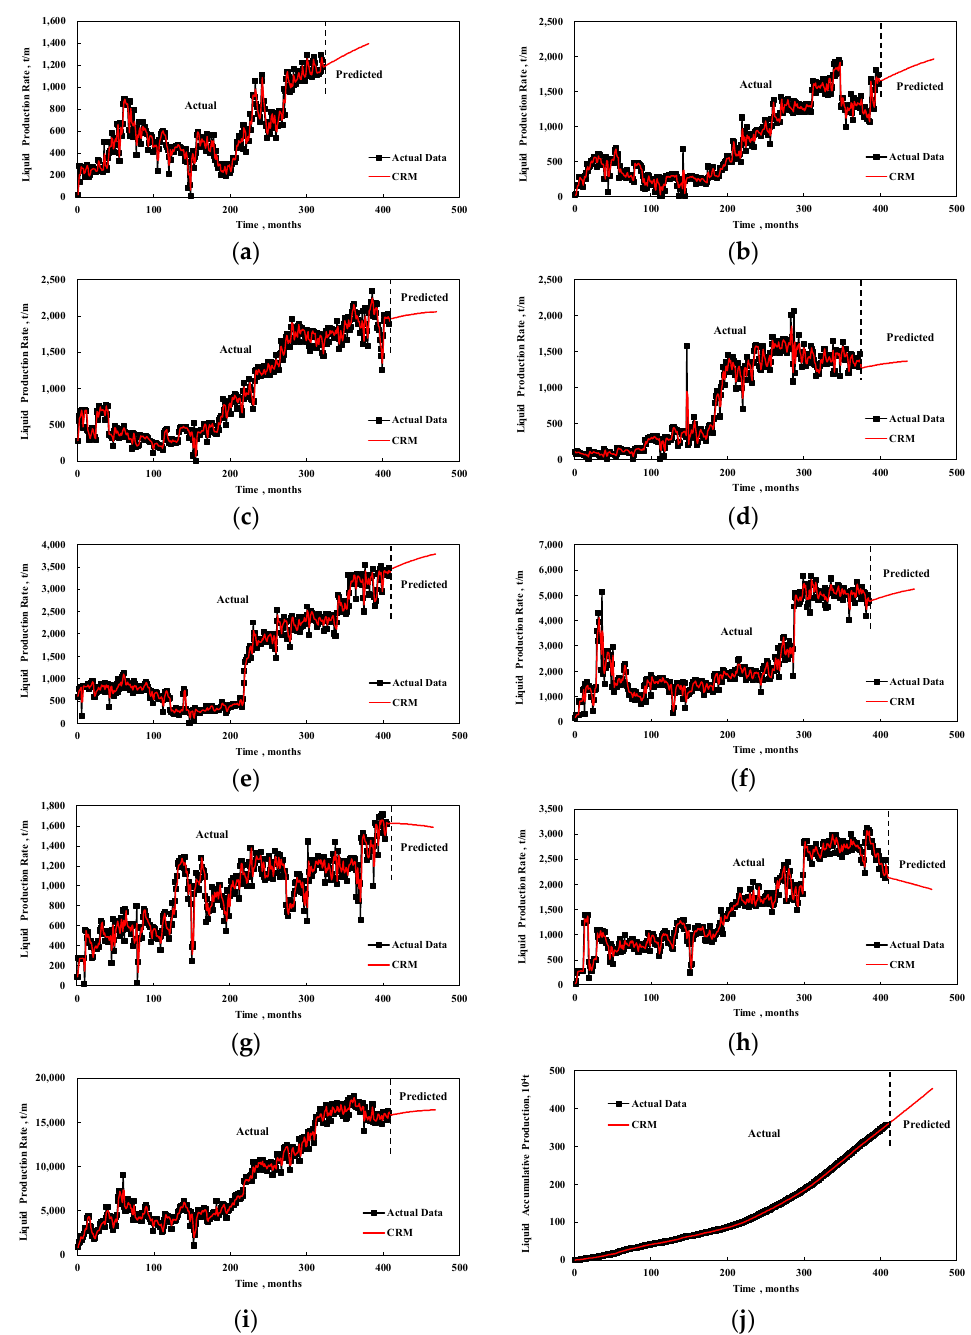
Figure 5. Comparison between actual liquid production data and calculated liquid production data by combining modified CRM and waterflooding performance equation. ( a ) Producer 1499, ( b ) Producer 1500, ( c ) Producer 1501, ( d ) Producer 1511, ( e ) Producer 1512, ( f ) Producer 1519, ( g ) Producer 1520, ( h ) Producer 1521, ( i ) Liquid monthly production of the well group, ( j ) Liquid accumulative production of the well group.